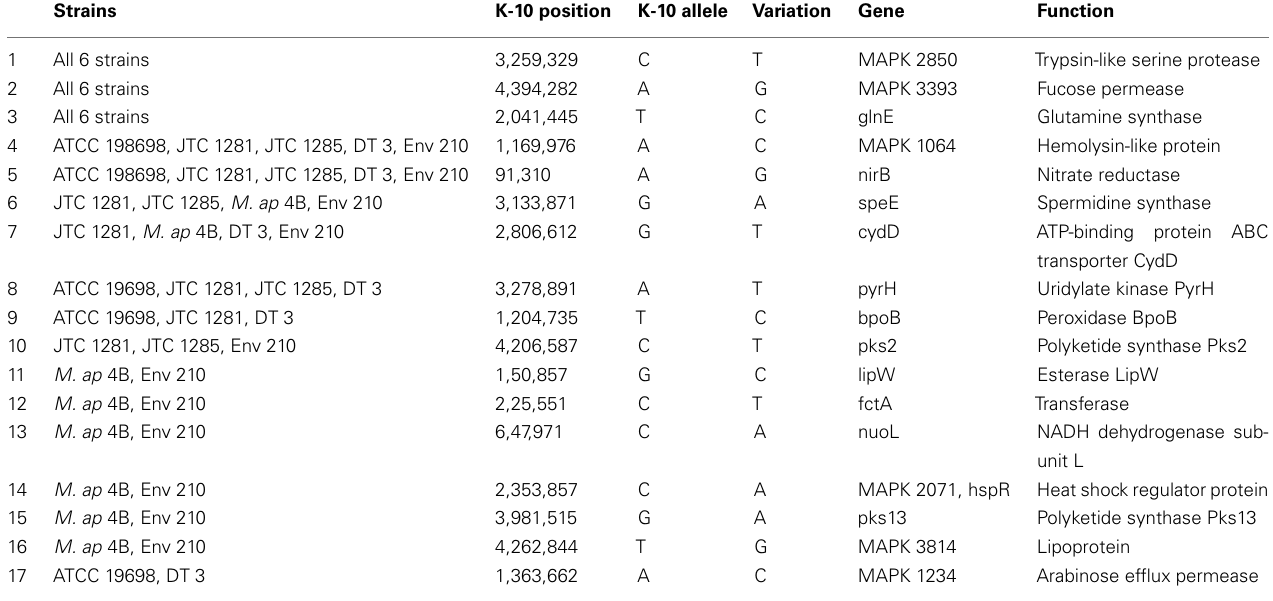
Table 4 |A list of non-synonymous SNPs in M. ap genome resulted in more than one strain. Strains